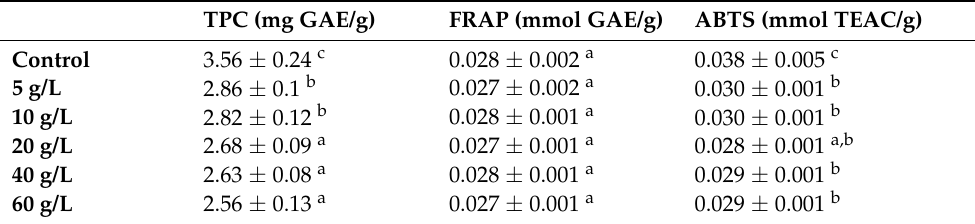
Table 3. Total phenolic compounds and anti-oxidant activity (ferric reducing antioxidant power -FRAP, and of A. platensis grown at different salinities ( n = 3, ± SD). The different superscript letters denote statistically significant differences. TPC (mg GAE/g) FRAP (mmol GAE/g) ABTS (mmol TEAC/g)